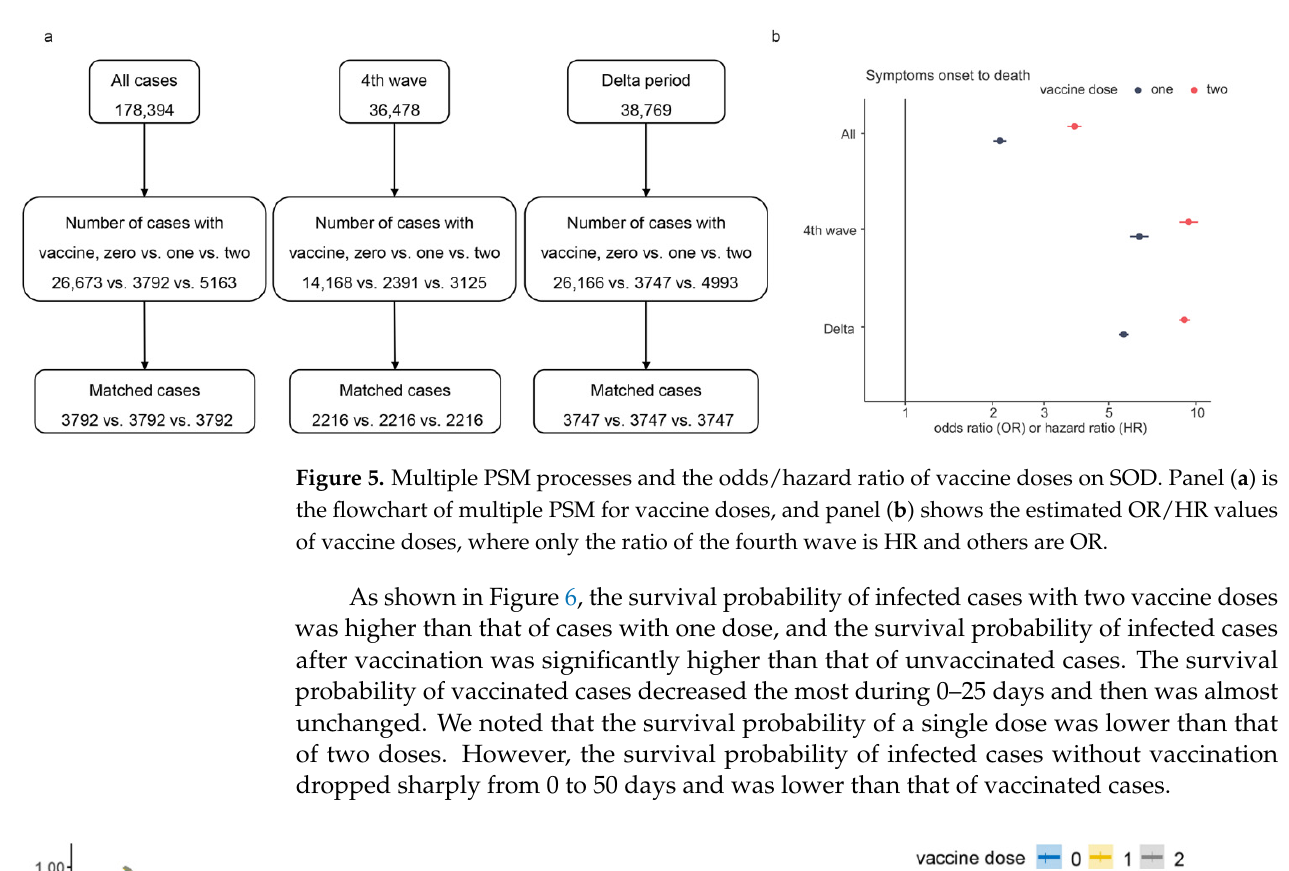
Figure 6. Survival curves of SOD estimated by Kaplan–Meier estimator under different vaccine doses.